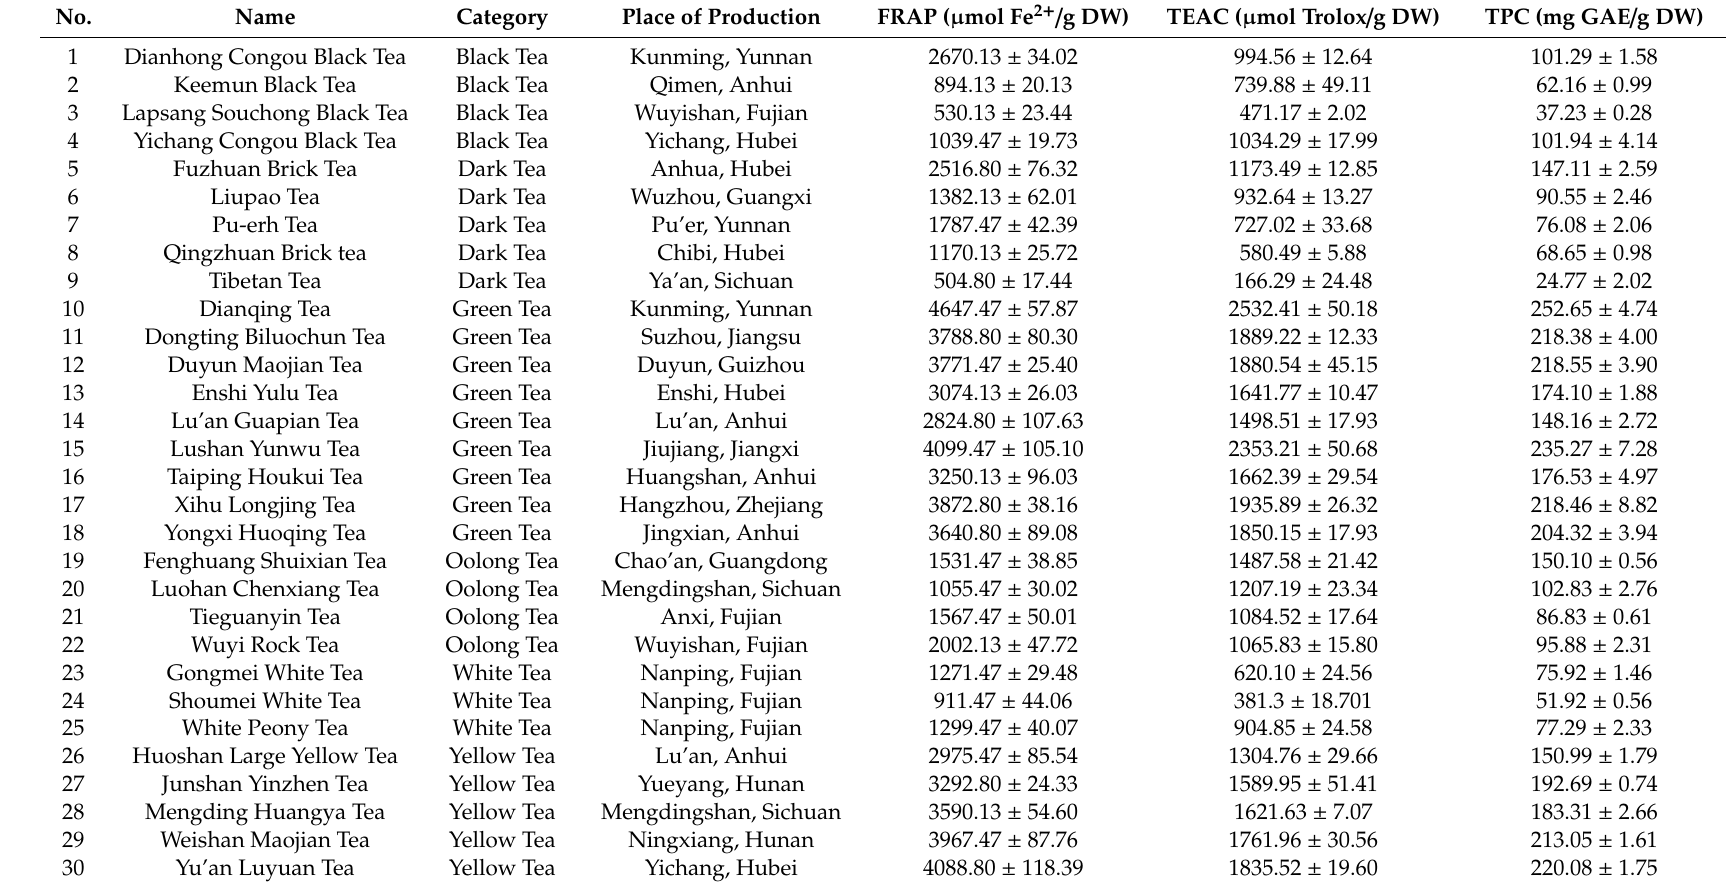
Table 1. The antioxidant capacities and total phenolic contents (TPC) of 30